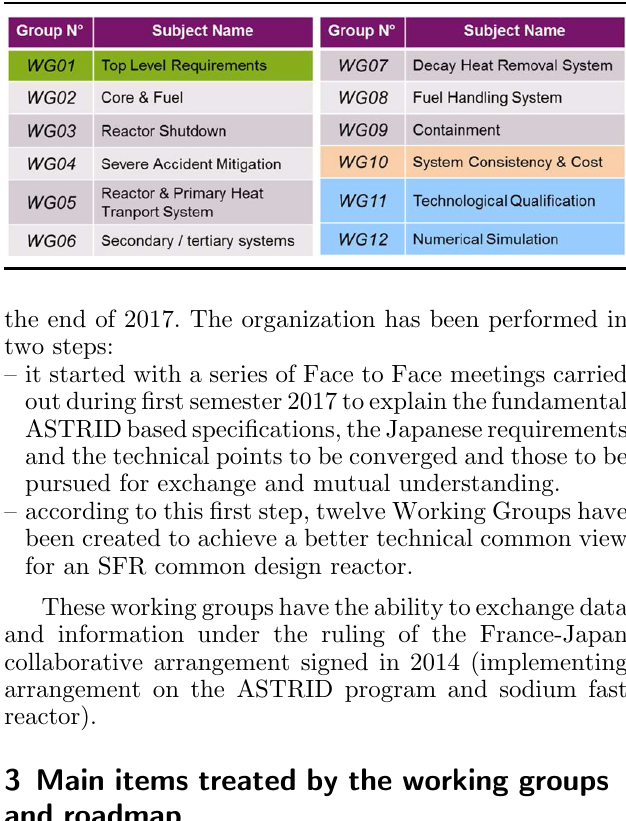
Table 1. Table of the corresponding Working